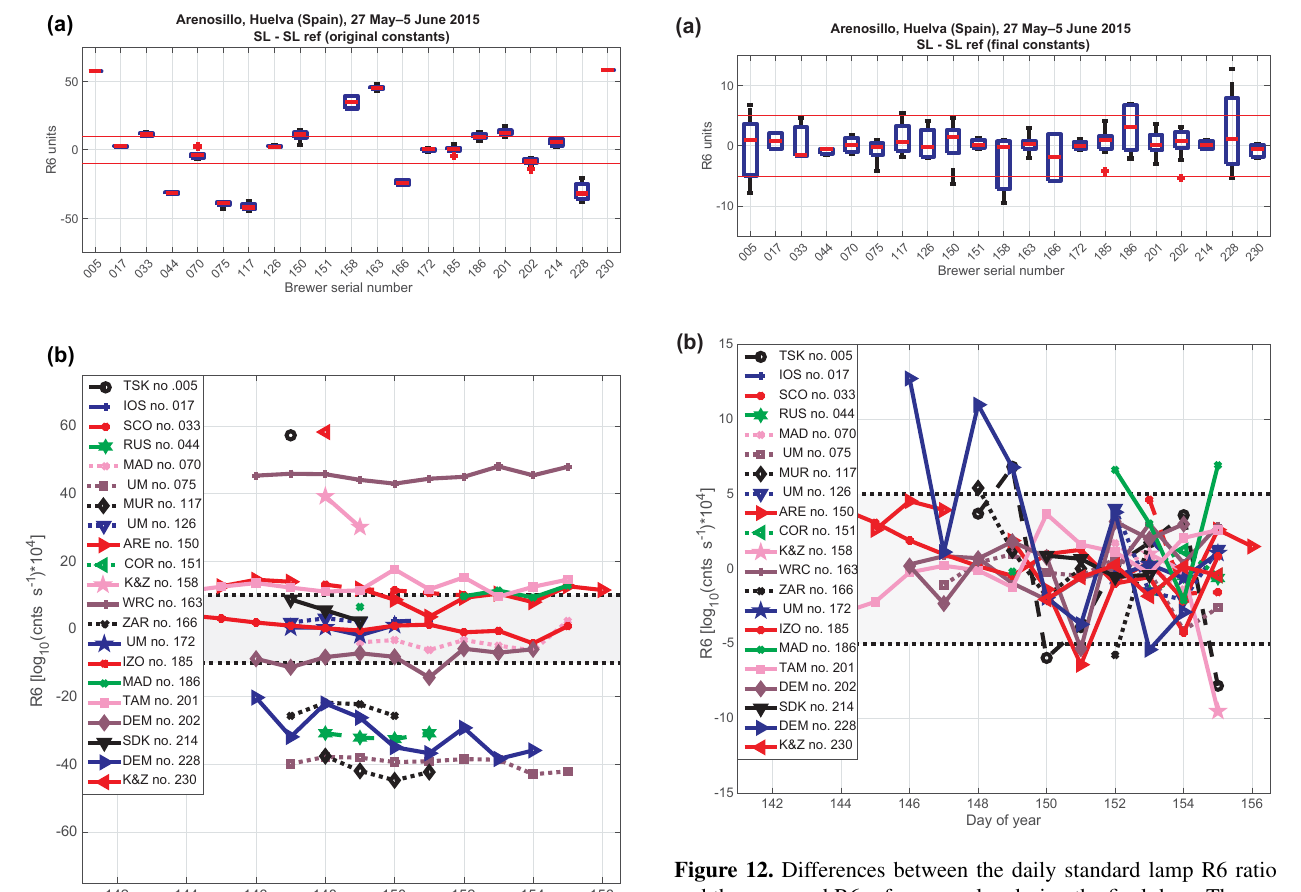
Figure 12. Differences between the daily standard lamp R6 ratio and the proposed R6 reference value during the final days. The up- per panel shows the mean value for each instrument, and the lower panel the daily mean during the campaign. It is important to get an stable R6 value during the final days, within the ± 5 units range ( ∼ .5% in ozone), to stabilise the reference value of the